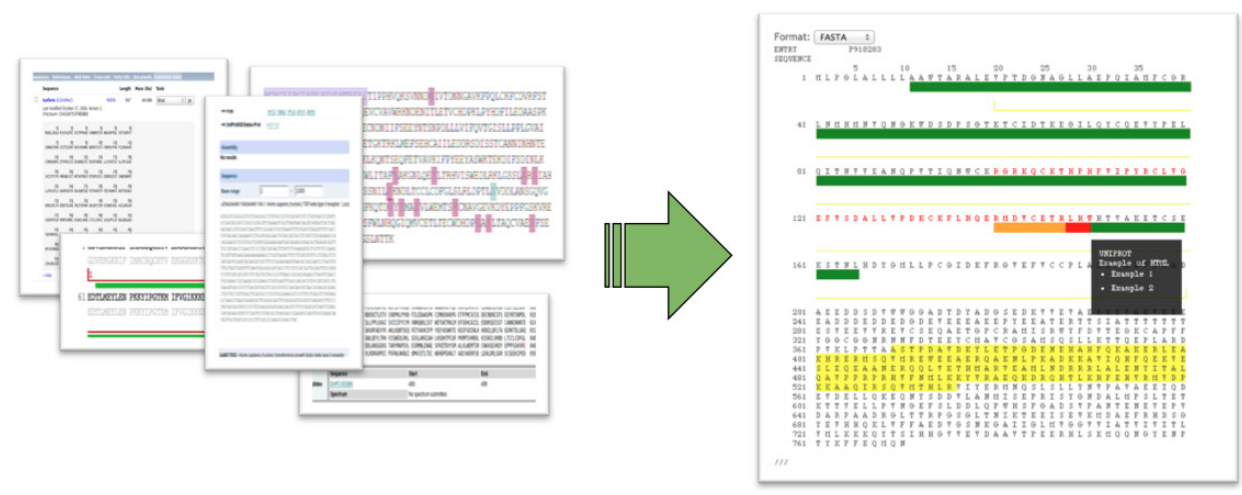
Figure 1. Multiple representations compiled as one flexible BioJS